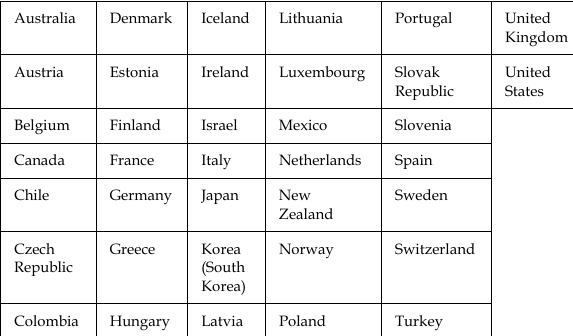
Figure 1 Thirty-seven OECD